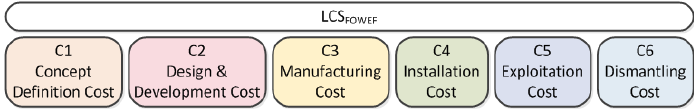
Figure 1. General view of the methodology proposed.